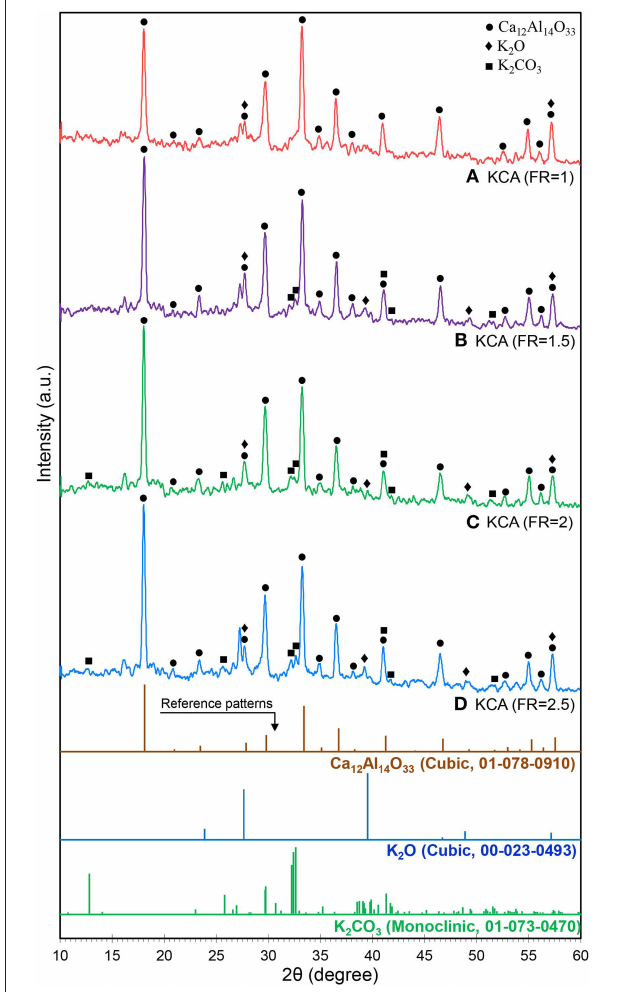
FIGURE 3 | XRD patterns of synthesized KOH/Ca 12 Al 14 O 33 nanostructured catalysts with various fuel ratios: (A) KCA(FR = 1), (B) KCA(FR = 1.5), (C) KCA(FR = 2), and (D) KCA(FR =